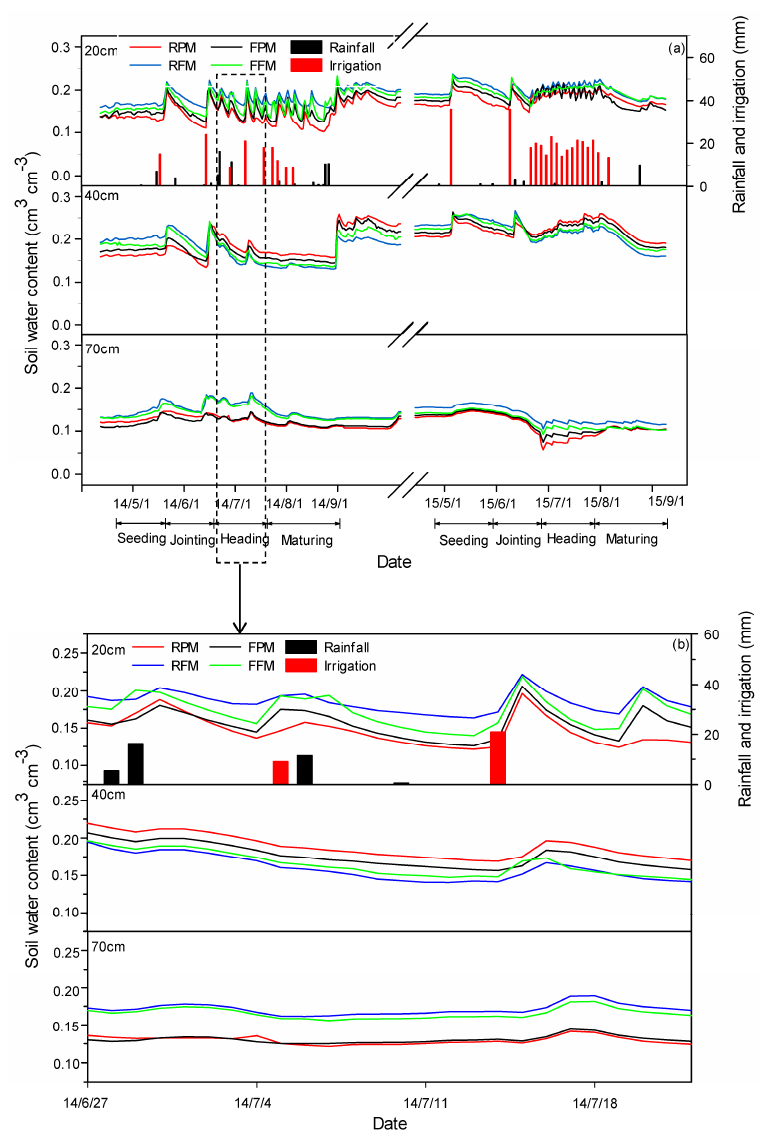
Figure 4. Soil water content in the top 70-cm of the soil in different treatments ( a ) during the growth period in 2014 and 2015 and ( b ) during the heading stage in 2014.